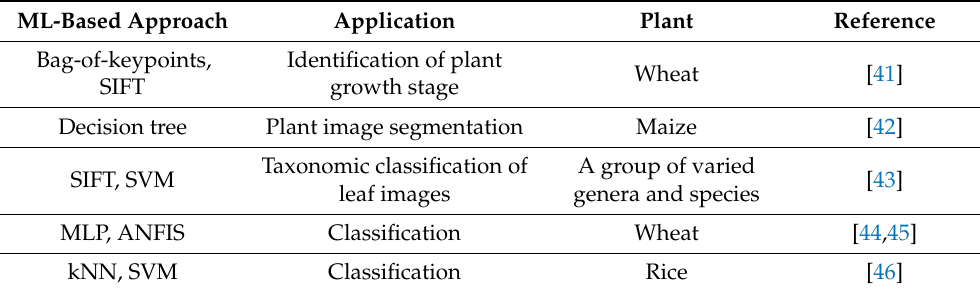
Table 1. Examples of ML-based approaches that have been applied in phenotyping tasks. ML-Based Approach Application Plant Reference Bag-of-keypoints, Identification of plant Wheat [41] SIFT growth stage Decision tree Plant image segmentation Maize [42] Taxonomic classification of A group of varied SIFT, SVM [43] leaf images genera and species MLP, ANFIS Classification Wheat [44,45] kNN, SVM Classification